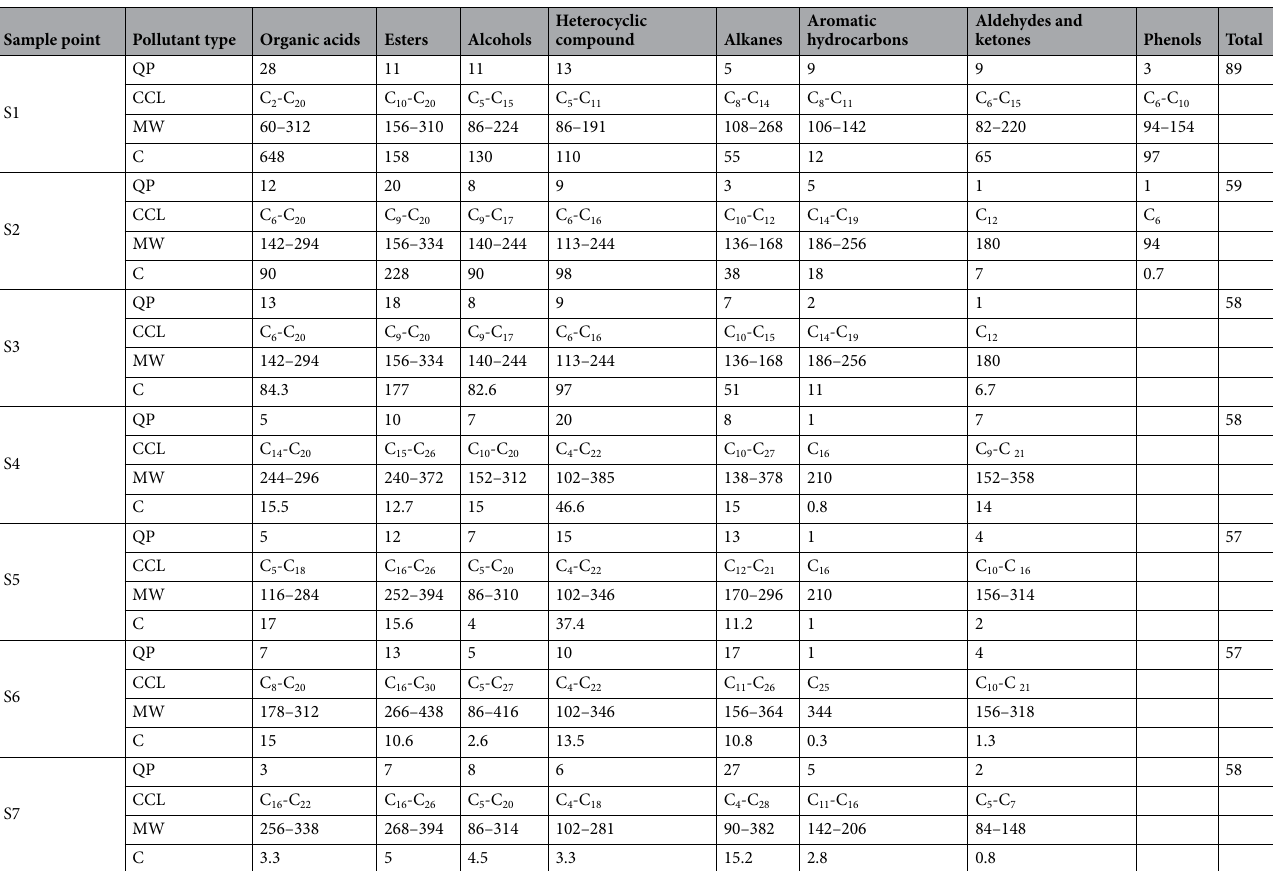
Table 3. Organic pollutants in wastewater samples collected from different treatment units in a petroleum refinery wastewater plant. S1-7 sample point 1–7; QP quantity of pollutants; CCL carbon chain length range; MW relative molecular weight distribution range; concentration (mg L −1